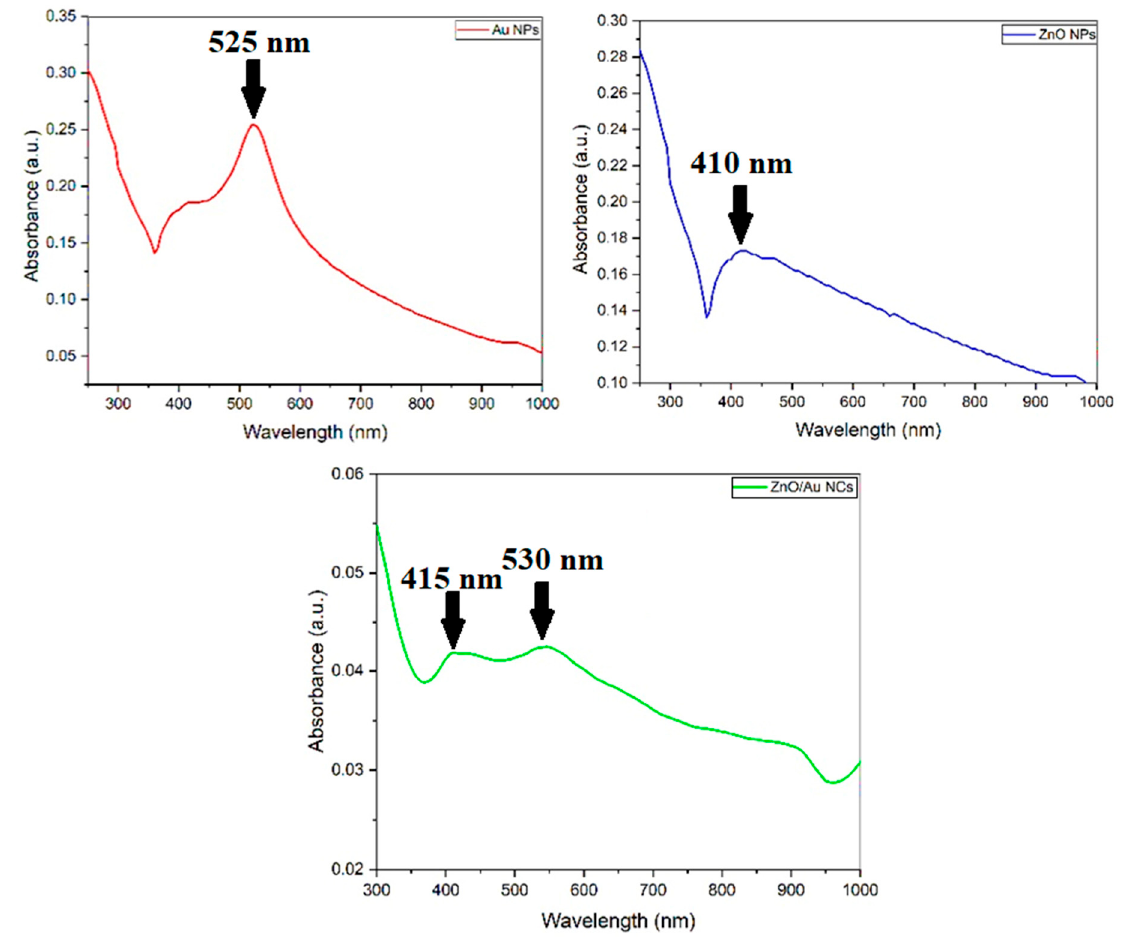
Figure 3. UV-vis spectroscopy of Au NPs, ZnO NPs, and Au/ZnO NCs, prepared by LA at 800 mJ.